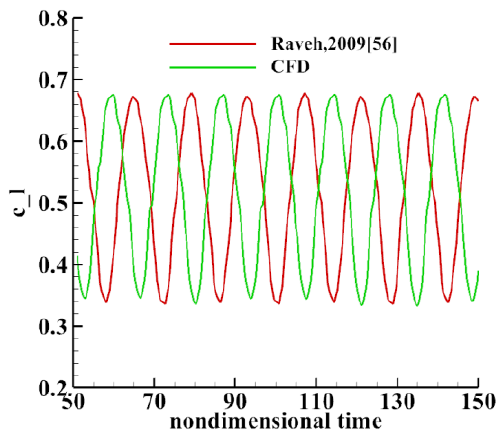
Figure 3. Comparison and validation of unsteady numerical results.